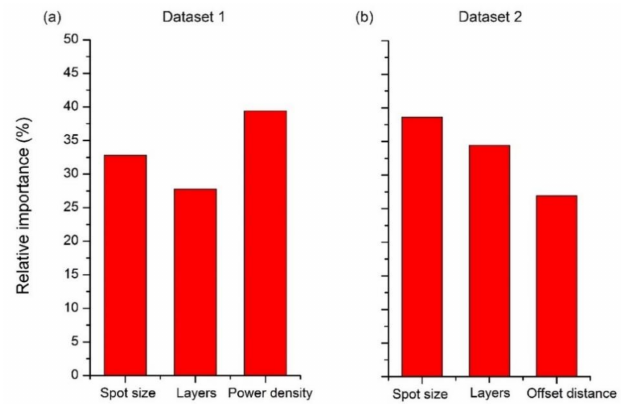
Figure 8. Relative importance ( RI ) of inputs for the predicted residual stresses using the ANN model using Garson’s algorithm for ( a ) single-shot laser peening data (dataset 1) and ( b ) multiple-shot laser peening data with overlap (dataset